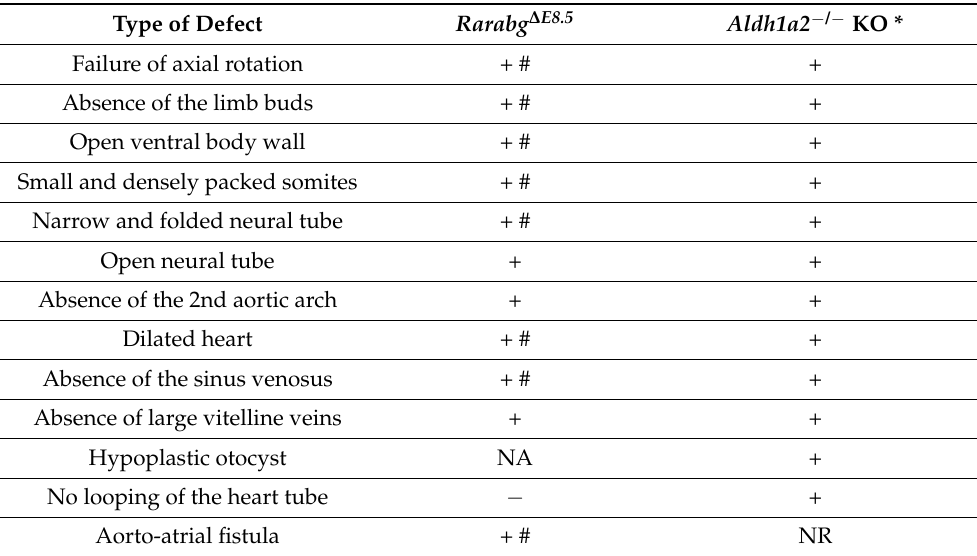
Table 3. Comparison of the abnormalities displayed by Rarabg ∆ E8.5 mutants (n = 3) and Aldh1a2 − / − KO mutants analysed at E9.5. +, Present; − , Absent. # These abnormalities are completely penetrant. NA, not applicable as the invagination of the otic placode was still underway in all these mutants; NR not reported. * From [33,34].